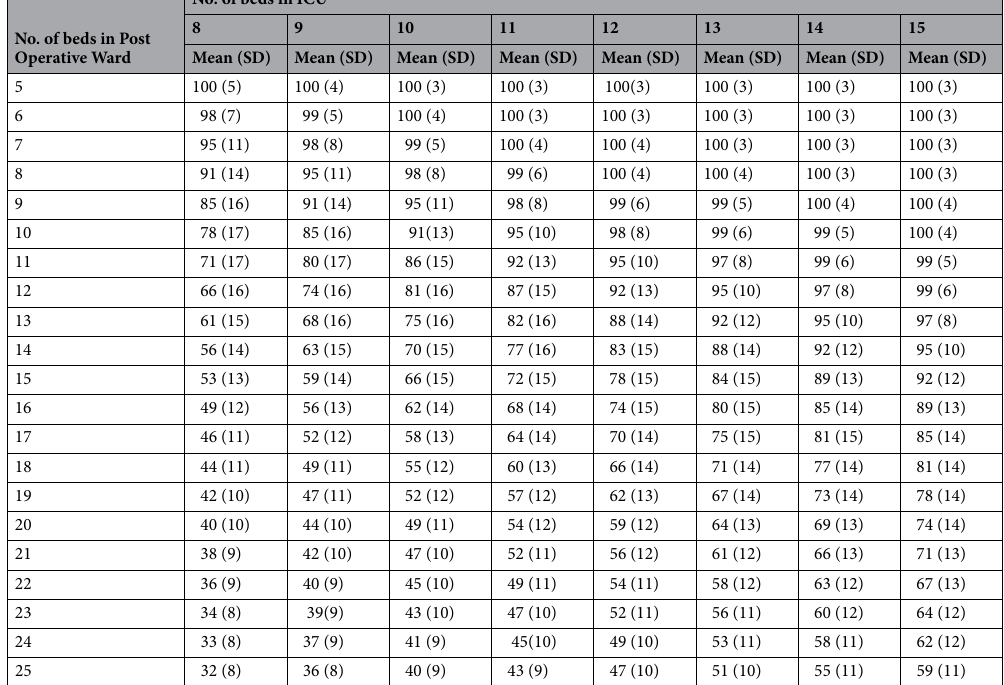
Table 1. Bed occupancy rate (%) in post operative ward (POW) for different number of beds in ICU and POW. SD standard deviation.